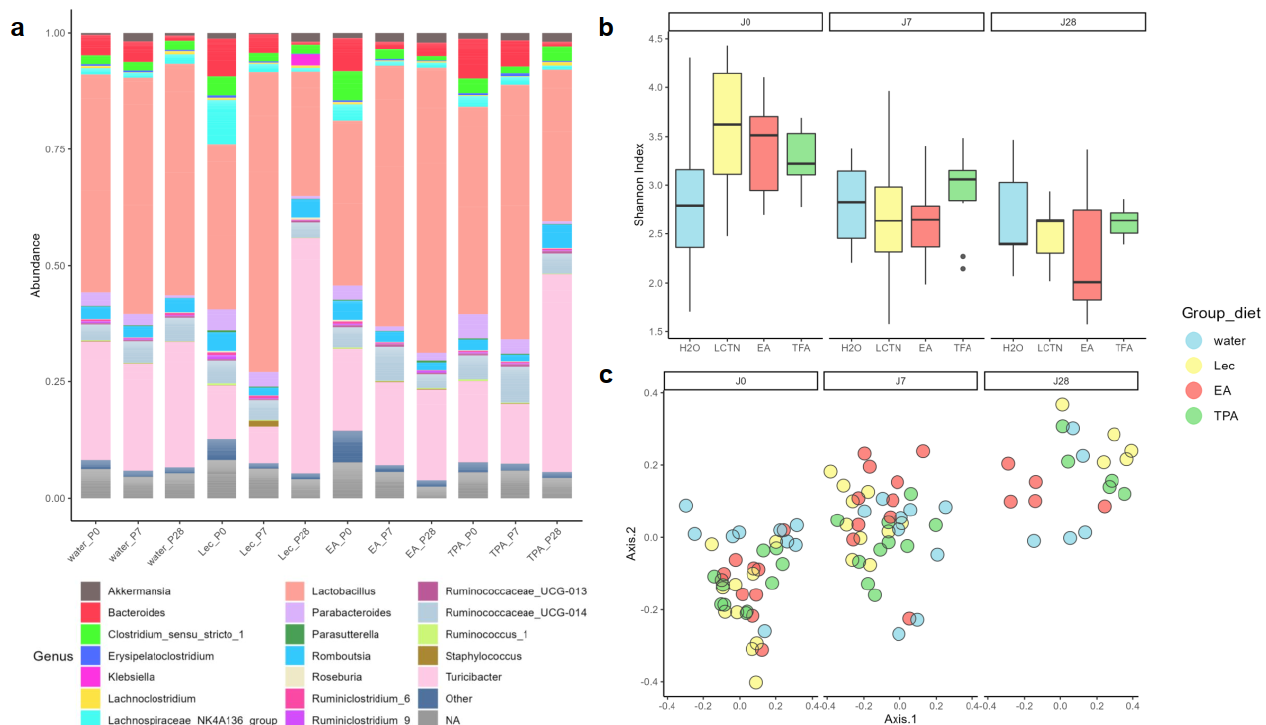
Figure 3. Compositional differences in GM between mice supplemented with water, lecithin vesicle, TPA, and EA: ( a ) compositional bar chart; ( b ) alpha diversity, Shannon index; and ( c ) beta diversity, Bray–Curtis.